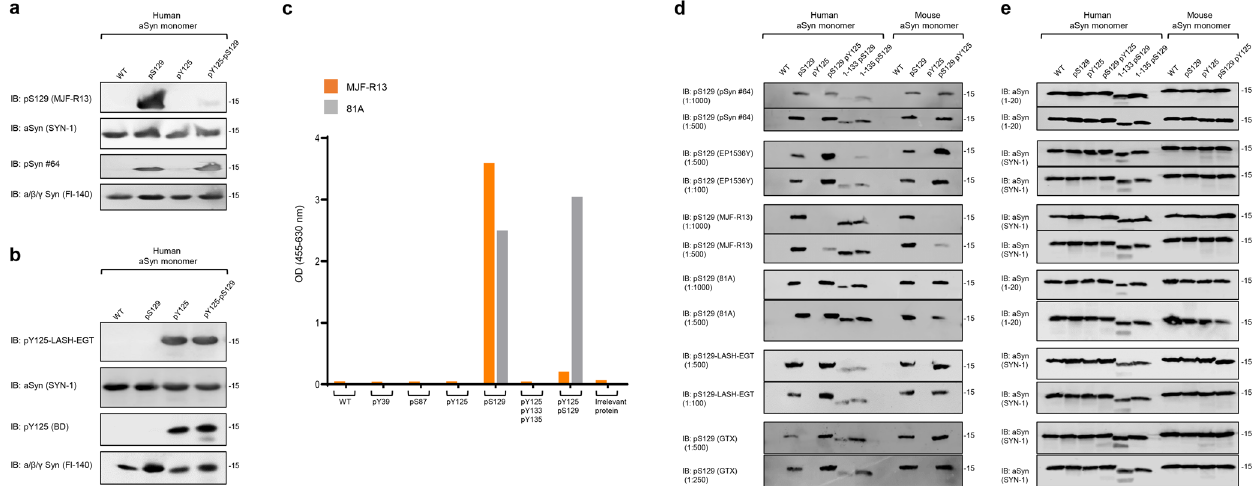
Fig. 2 PTMs nearby S129 residue interferes with the capacity of some pS129 antibodies to detect pS129-aSyn. The capacity of human or mouse recombinant monomeric aSyn (WT or modi fi ed by speci fi c PTMs) to be detected by pS129 commercial antibodies (pSyn#64, MJF-R13, 81A, EP1536Y, and GTX) or the LASH-EGT homemade pS129 antibody was assessed by WB ( a , b , d ) or ELISA ( c ). a , b Forty nanograms of human recombinant monomeric aSyn unphosphorylated (WT) or phosphorylated at the S129 residue (pS129) or di-phosphorylated (pY125/pS129) were detected by WB using total aSyn antibodies (SYN-1 or Fl-140 α / β / γ synuclein) combined with either a commercial (MJF-R13 or pSyn#64) and homemade (LASH-EGT) pS129 antibodies or b commercial pY125 antibody (BD) or the homemade antibody LASH-EGT-pY125. c ELISA con fi rmed that MJF-R13, but not 81A, is no longer able to detect pS129-aSyn when aSyn was di-phosphorylated (pY125/pS129). d , e One- hundred nanograms of unmodi fi ed aSyn (WT) or phosphorylated aSyn at S129 and/or Y125 residues (respectively named pS129, pY125 or pS129/pY125) full length or truncated after residues 133 (1-133/pS129) or 135 (1-135/pS129) were detected by WB using pS129 antibodies ( d ) or total aSyn antibodies (SYN-1 or LASH-EGT 1-20) ( e ). All blots were derived from the same experiment and were processed in